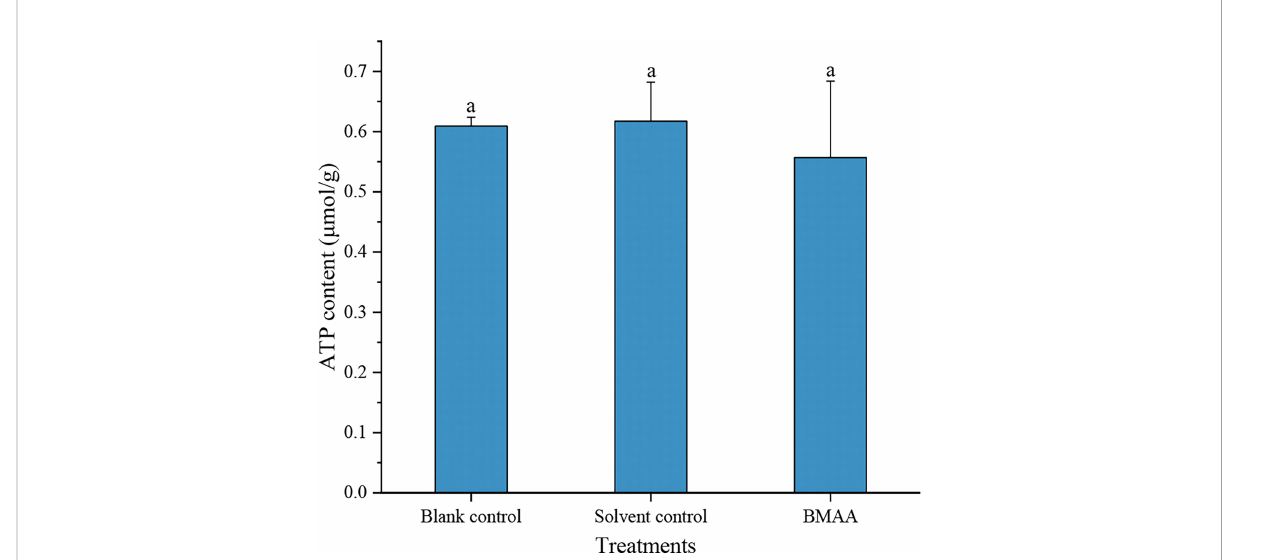
FIGURE 5 The ATP concentrations in marine medaka ( Oryzias melastigma ) embryos at 9 days post fertilization (DPF) in different treatments. An equivalent volume of 2 mM HCl was added into the culture well as a solvent control